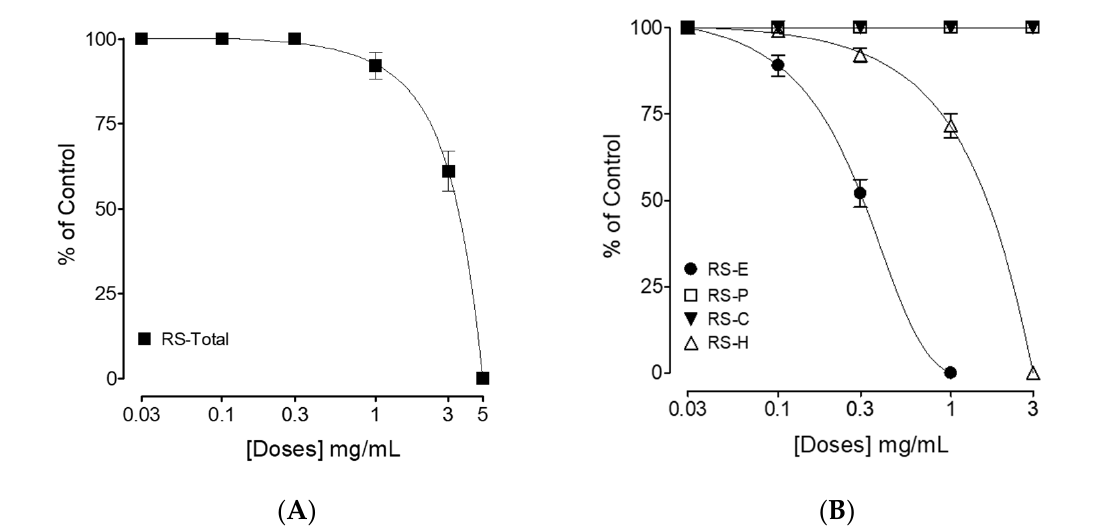
Figure 1. Concentration-dependent inhibitory (bronchodilatory) effects of ( A ) R. stricta toal extract (RS-Total), ( B ) Factions namely; R. stricta ethyl acetate (RS-E), R. stricta petroleum (RS-P), R. stricta chloroform (RS-C) and R. stricta aqueous (RS-H) against carbachol (CCh; 1 μ M) induced contraction in isolated guinea pig tracheal preparations. Symbols represent mean ± SEM; n = 4.